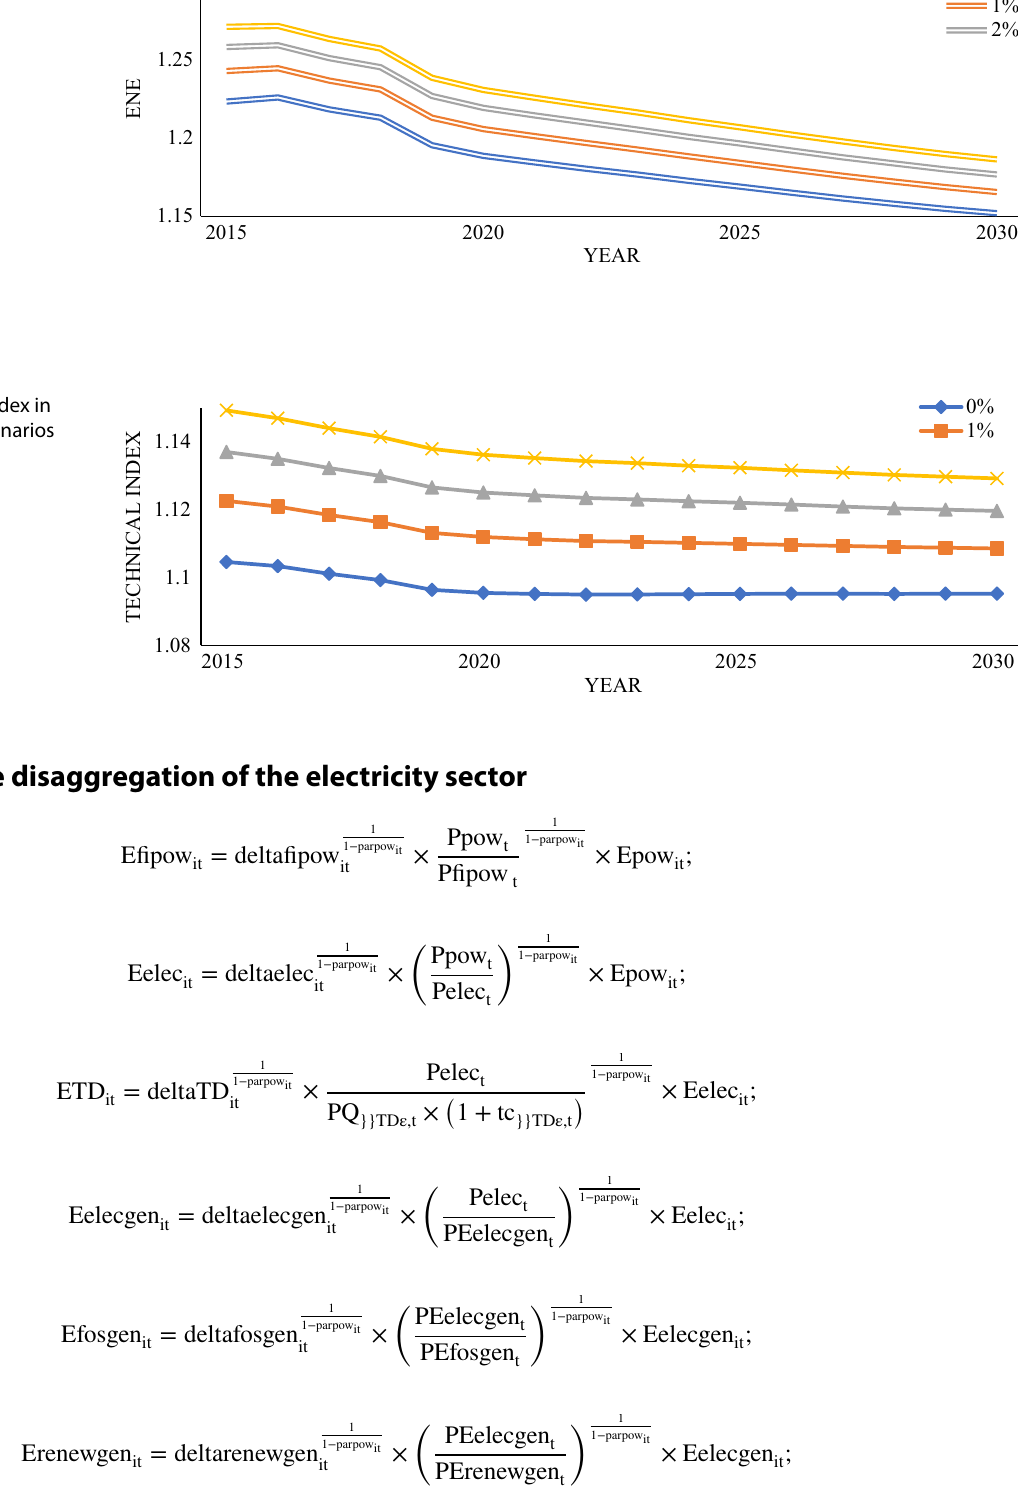
Fig. 13 The ENE in the base- line and tax scenarios